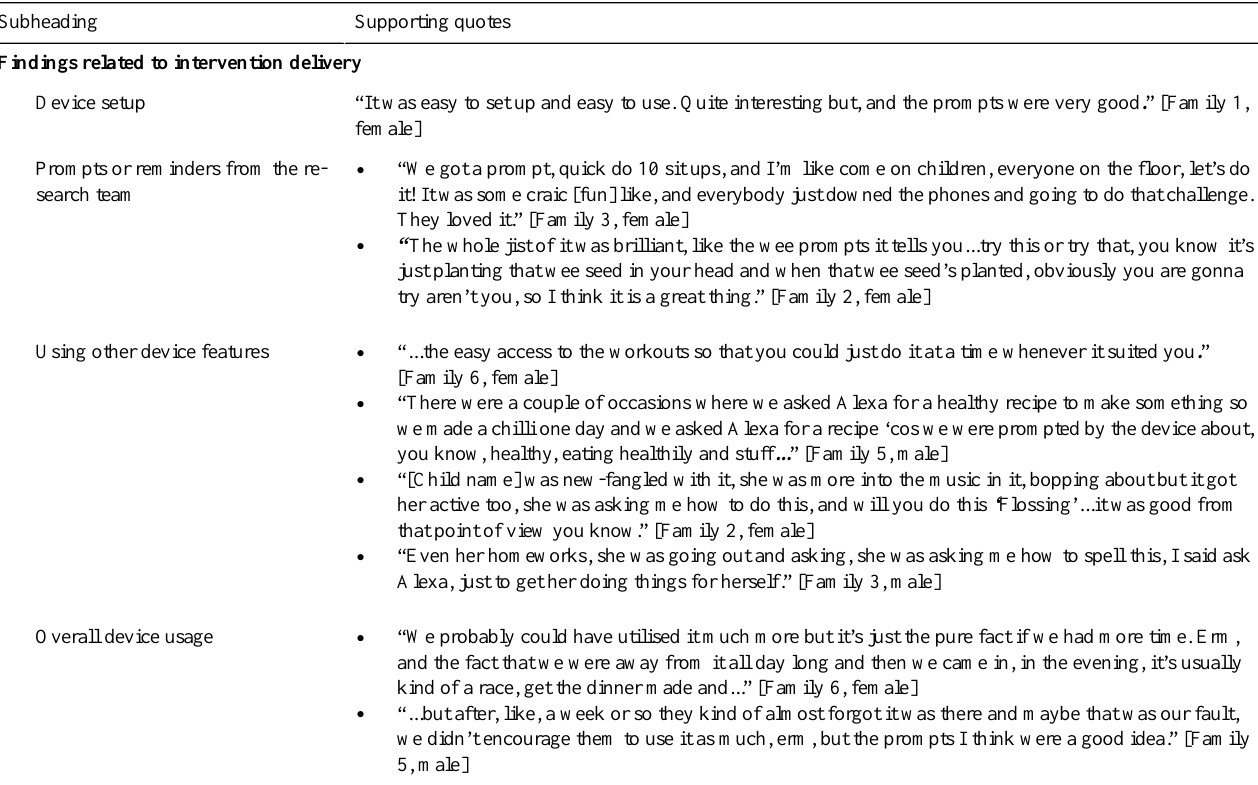
Table 5. Supporting quotes from family focus groups and semistructured